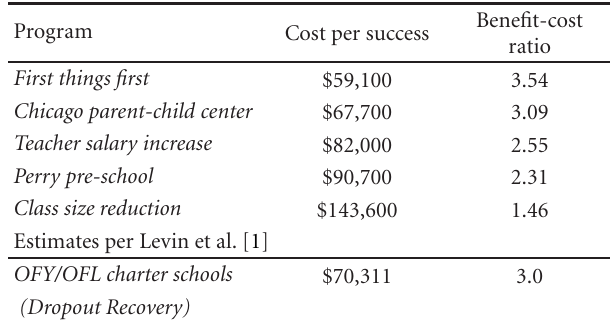
Table 7: Benefit-cost ratios of alternative dropout prevention